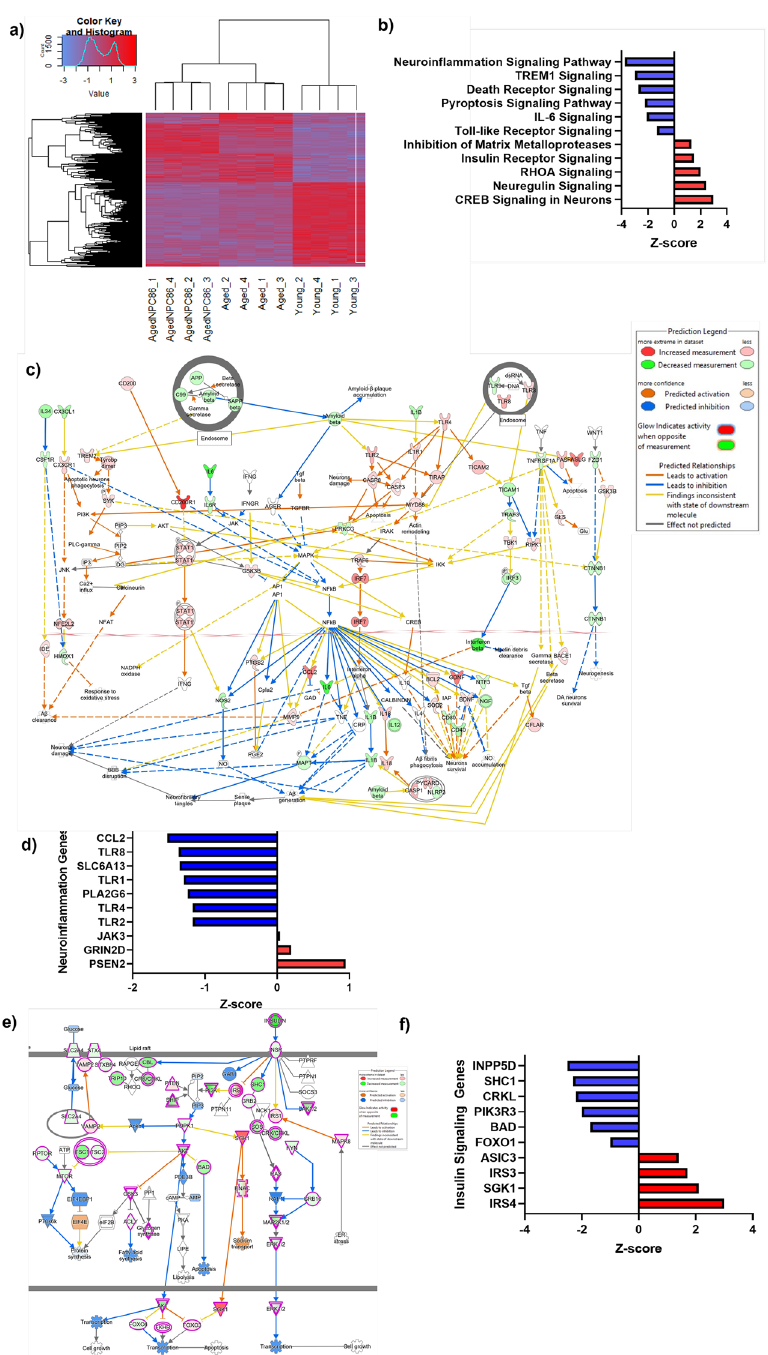
Figure 6. RNAseq Analysis of hippocampal tissue indicates NPC86 reduces neuroinflammation and increases insulin signaling in aged mice. ( a ) Heatmap shows hierarchical clustering of differentially expressed RNA transcripts in hippocampus of young, aged, and aged mice treated with NPC86 (2 FC, p-value < 0.05). Expression levels are represented by color and scale indicated in legend. ( b ) Graph of top ten canonical pathways significantly affected between aged and aged + NPC86 mice demonstrating the most upregulated (z-score > 1.3) and the most downregulated (z-score < −1.3) pathways identified by Ingenuity Pathway Analysis. Horizontal bars denote different pathways based on z-score. Red color indicates activation while blue color indicates suppression. ( c ) Neuroinflammation Pathway generated by IPA with changes in gene expression in a NPC86 dependent manner ( d ) top genes in neuroinflammation pathway downregulated (blue) and upregulated (red) identified by z-score between aged and aged + NPC86. ( e ) Insulin Signaling Pathway generated by IPA with changes in gene expression in a NPC86 dependent manner ( f ) top genes in IR pathway downregulated (blue) and upregulated (red) were identified by z-score between aged and aged + NPC86 mice. ( g ) QPCR of individual genes identified by RNAseq in the neuroinflammation and insulin signaling pathways, normalized to β-actin levels, with aged set as reference (n = 3). Statistical analysis was performed by one-way ANOVA, **p < 0.01, ***p < 0.001, and ns not significant. h) STRING analysis of protein associations with ( h ) TLR ( i ) TLR8 and ( j ) IR